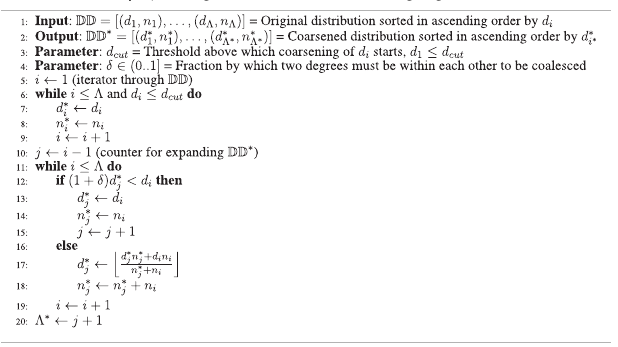
ALGORITHM 4 | Input Degree Distribution Coarsening